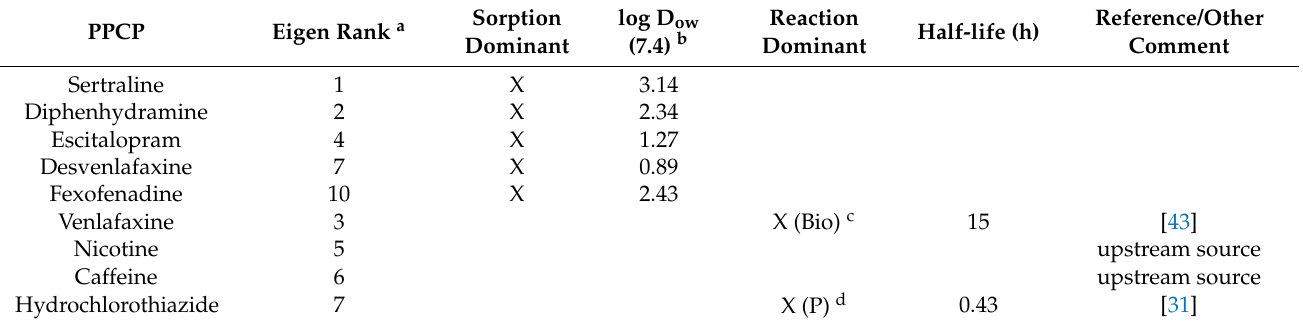
Figure 4. Box plot of sediment PPCP concentrations (ng/g dry wt) at site 8 for PPCPs quantified in >50% of the samples, where the sediment PPCP concentration were the maximum in the Cameron Run/Hunting Creek watershed. (Boxes represent 25th and 75th percentiles, midlines are the medians, and whiskers are the 5th and 95th percentiles). Table 1. Factors that account for PPCP compositional changes in TFPR surface water. Most important indicated by an X.